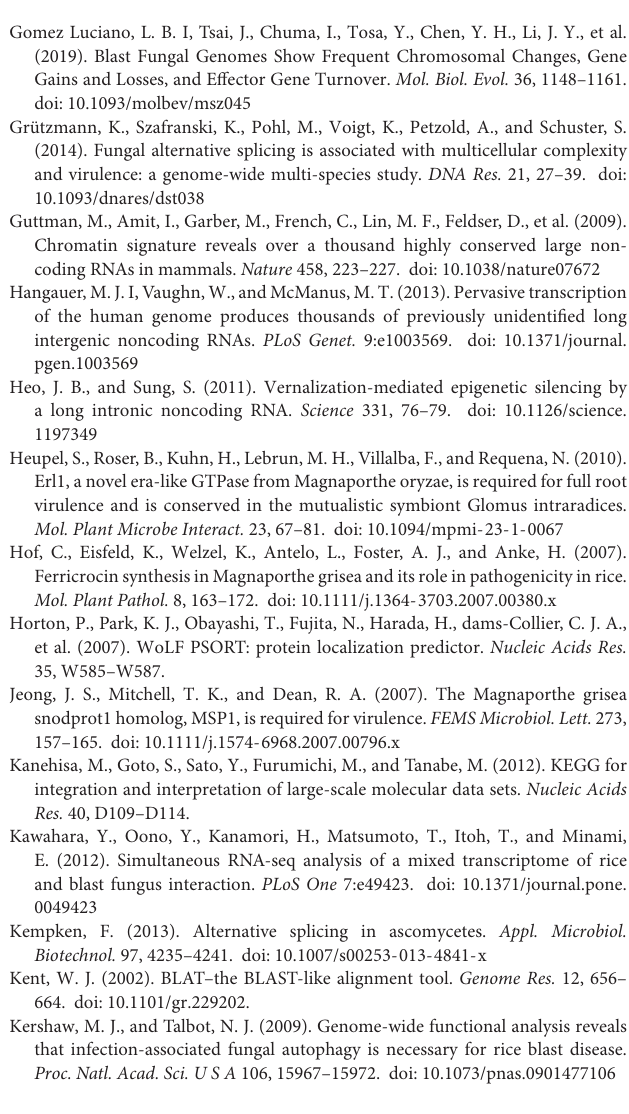
Supplementary Table 1 | Summary of RNA-Seq data. Supplementary Table 2 | Summary of assemblies. Supplementary Table 3 | Functional categories of genes with multiple isoforms. Supplementary Table 4 | Functions of genes with alternative splicing. Supplementary Table 5 | Functions of genes differentially expressed between conidia and